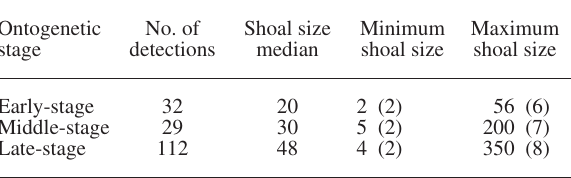
Table 2. – average shoal sizes (expressed by their medians) for the three ontogenetic stages and their ranges. Shoal size refers to number of individuals and numbers in parenthesis refer to abun- dance class category. ontogenetic